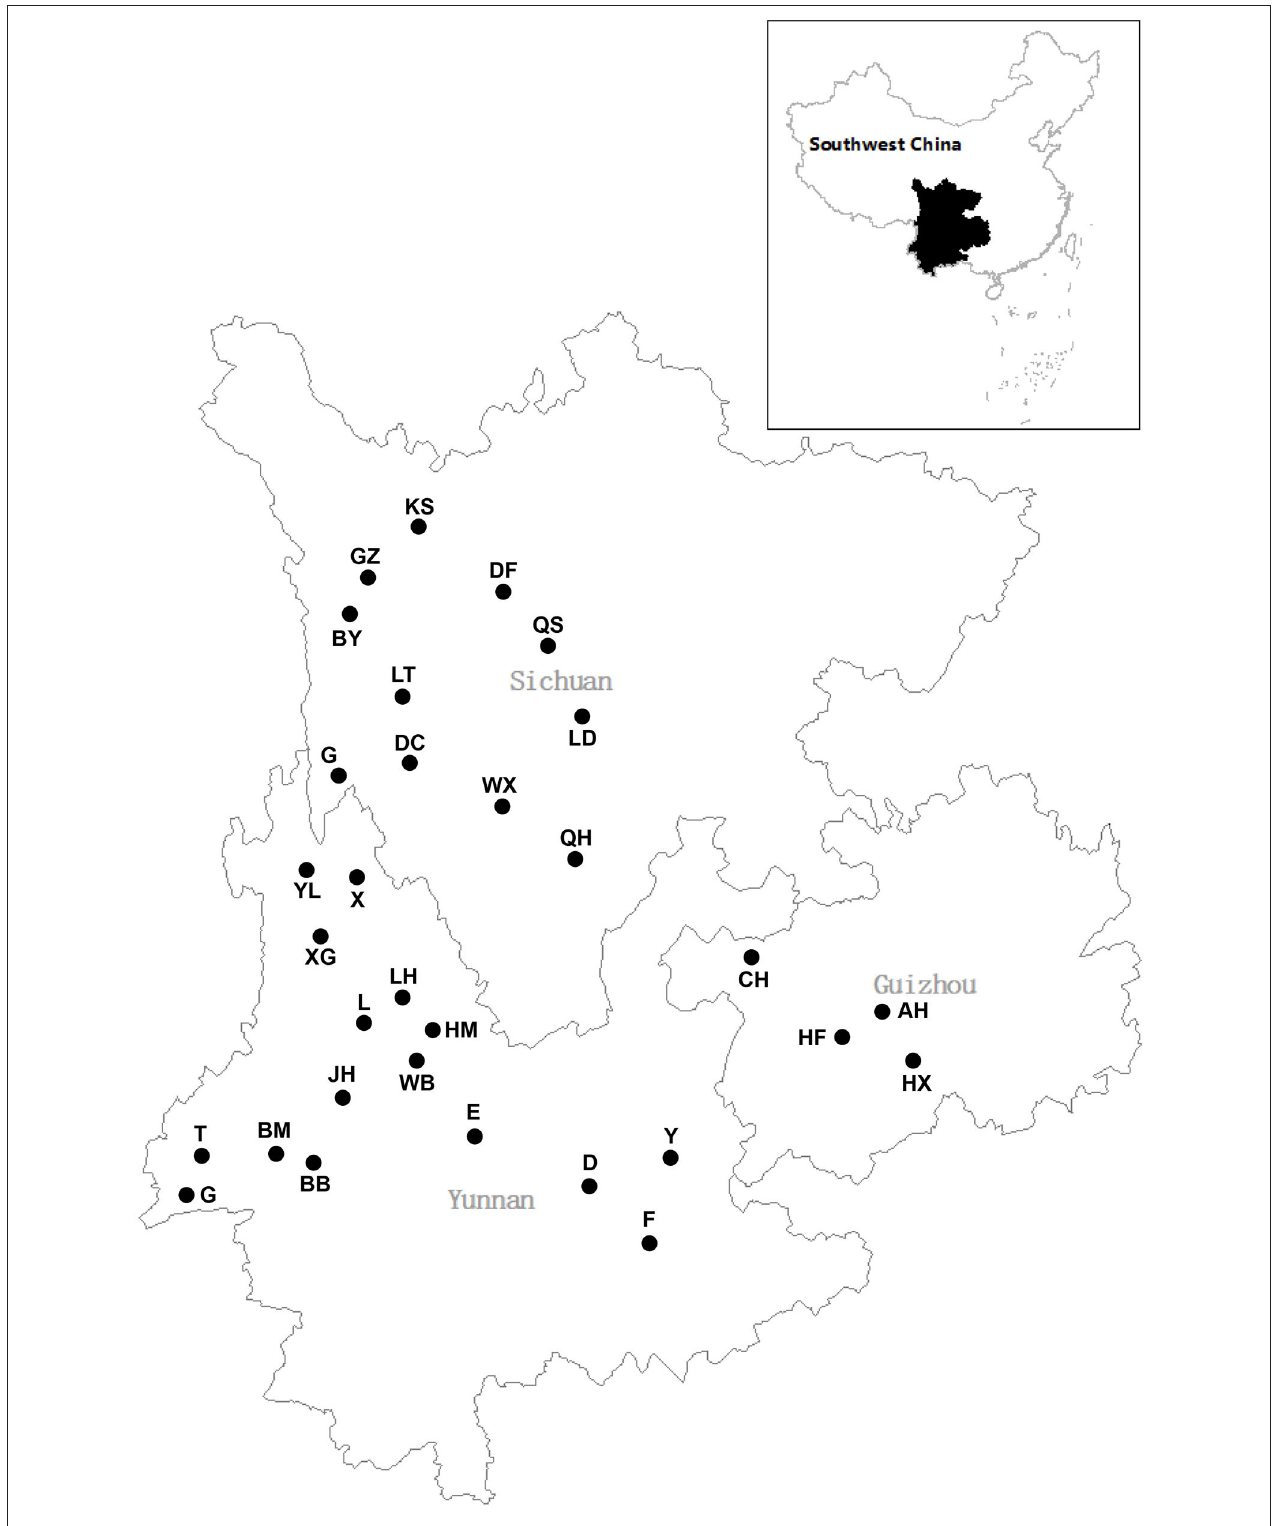
FIGURE 1 | Distribution of sampling sites.